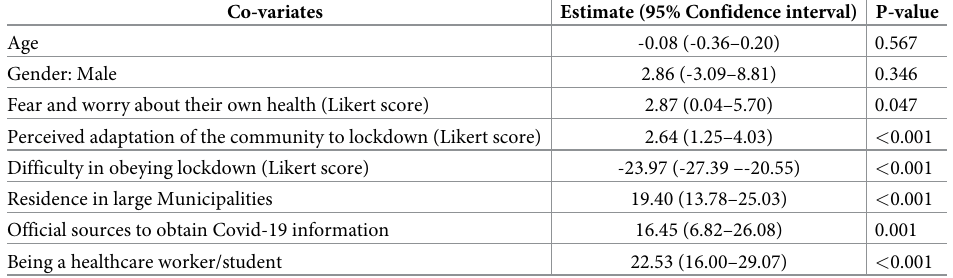
Table 5. Multiple linear regression investigating factors associated with adherence to the COVID-19 preventive